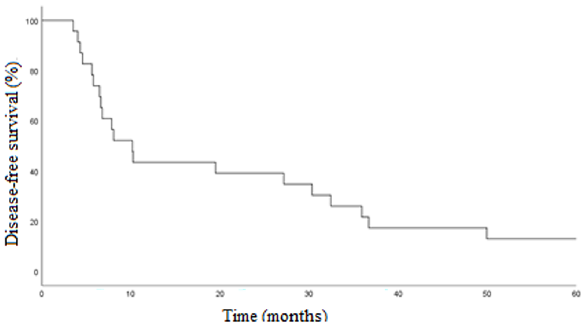
Figure 1 - Kaplan Meier curves showing the disease-free survival.